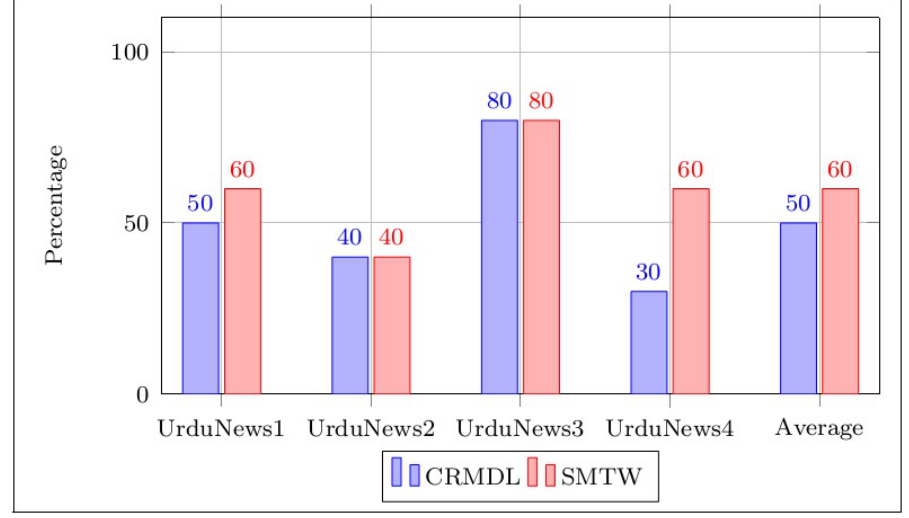
Figure 2. Precision comparison.